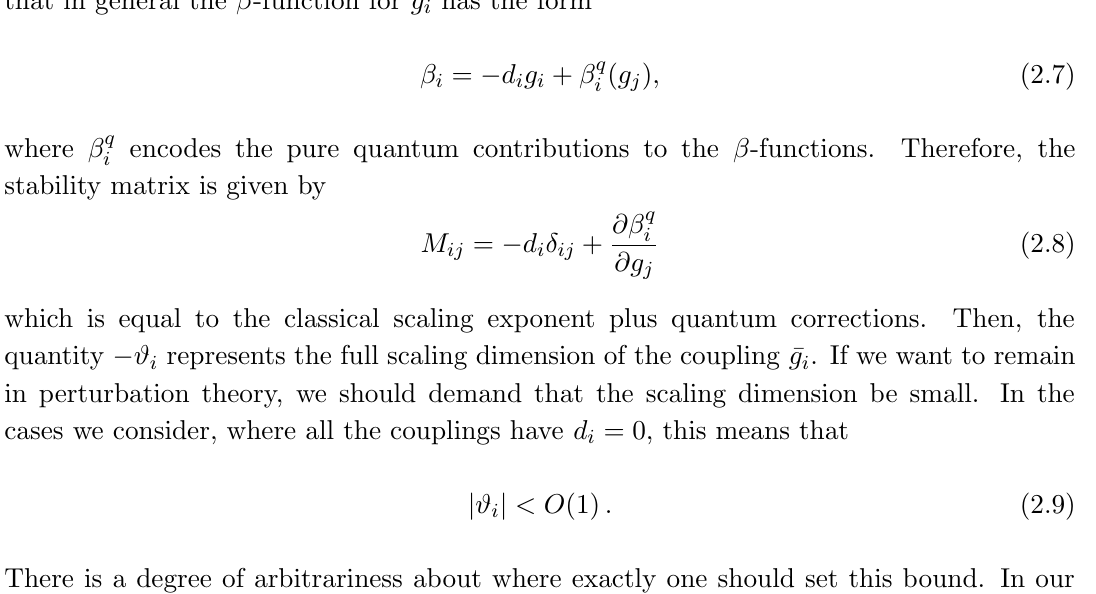
is shown in (cid:12)gure 1 as a white plane. In the same (cid:12)gure we depict the full UV critical surface in